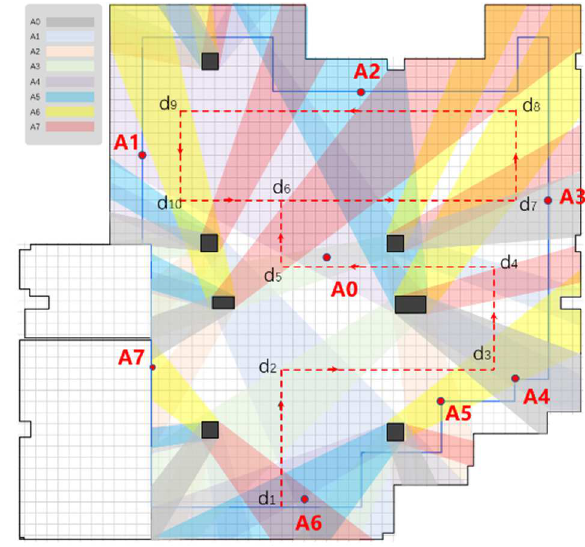
Figure 9. Distribution of NLOS shadows at anchors.